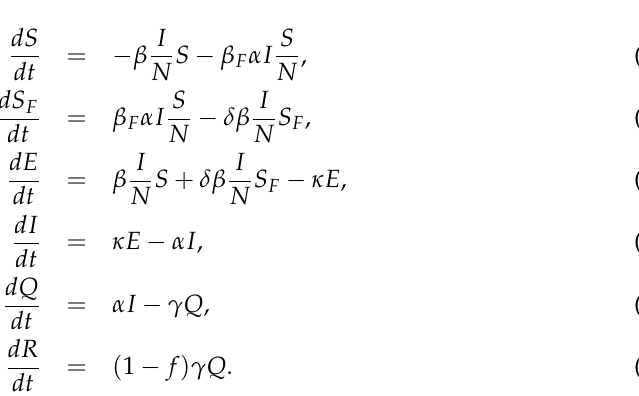
Figure 3. Flow diagram of the behavior-changed